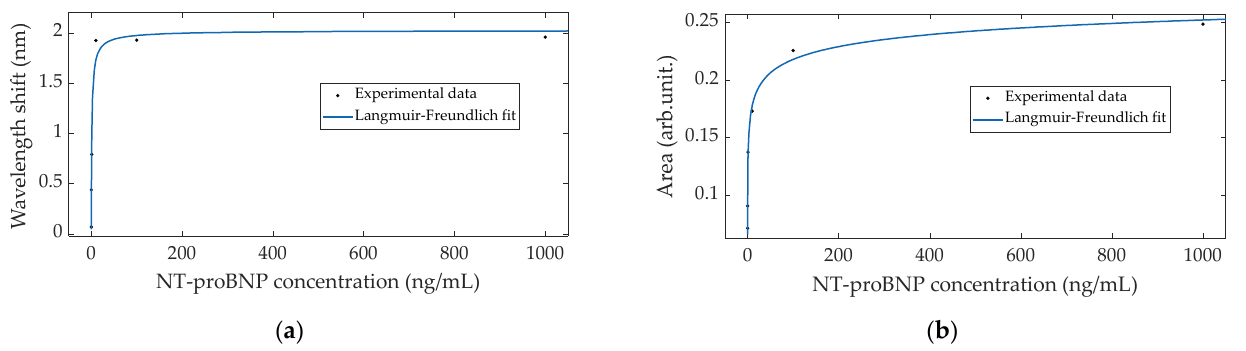
Figure 9. ( a ) Crossing point and ( b ) area variations as a function of NT-proBNP concentration, with the respective Langmuir–Freundlich fittings.